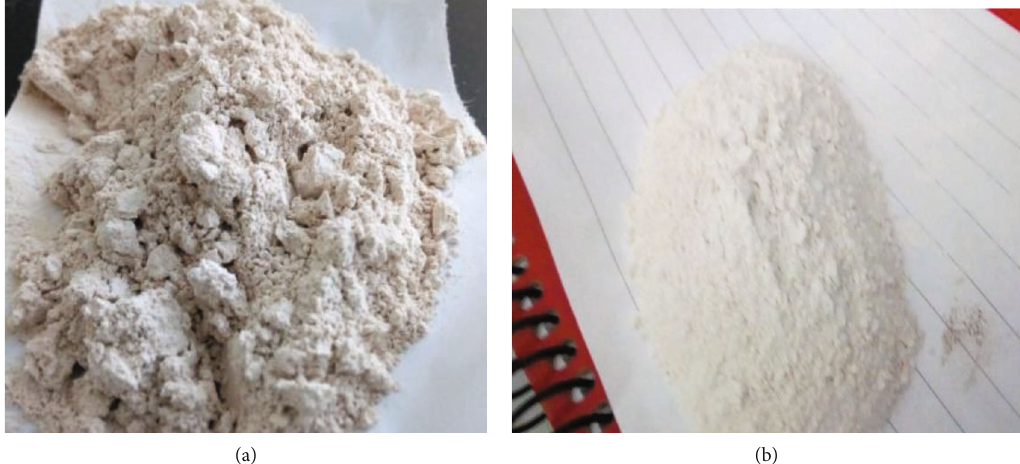
Figure 2: Photo images of (a) kaolin clay before and (b) after puri fi cation.